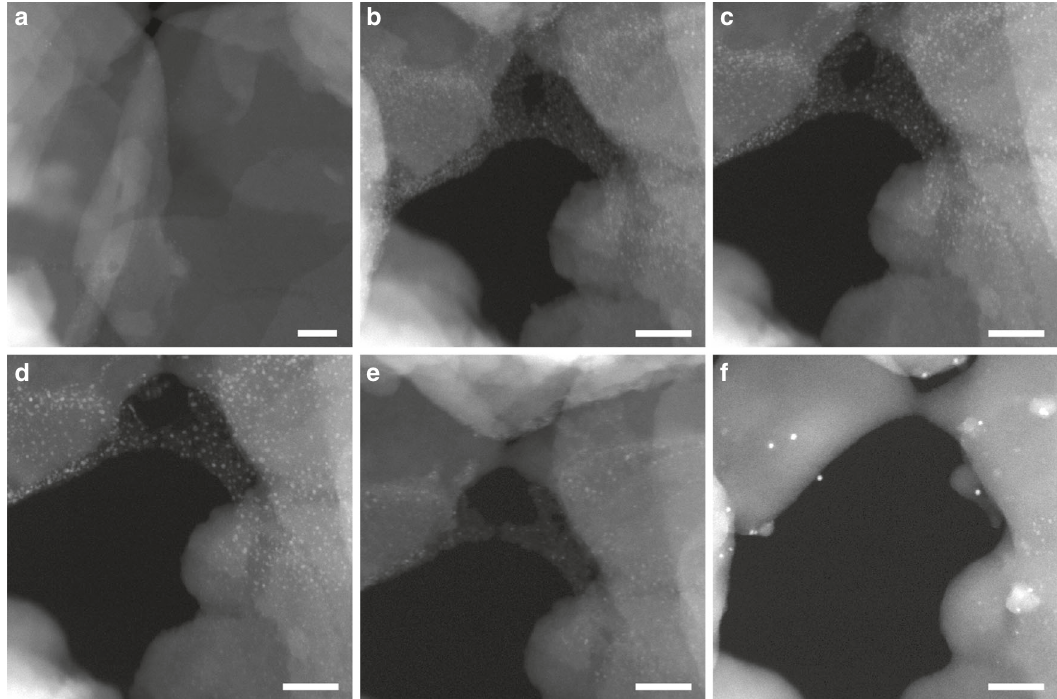
Fig. 1 Structural evolution of 0.17%Pt@MCM-22 under redox conditions. a 350 °C in H 2 for 15 min (0.1 torr), b 550°C in H 2 (0.1 torr) for 15 min, c 700 °C in H 2 (0.1 torr) for 15 min, d 800°C in H 2 (0.1 torr) for 10 min, e 500 °C in O 2 (0.1 torr) for 15 min, f 700 °C in O 2 (0.1 torr) for 15 min. Scale bar in all the images in this fi gure: 20